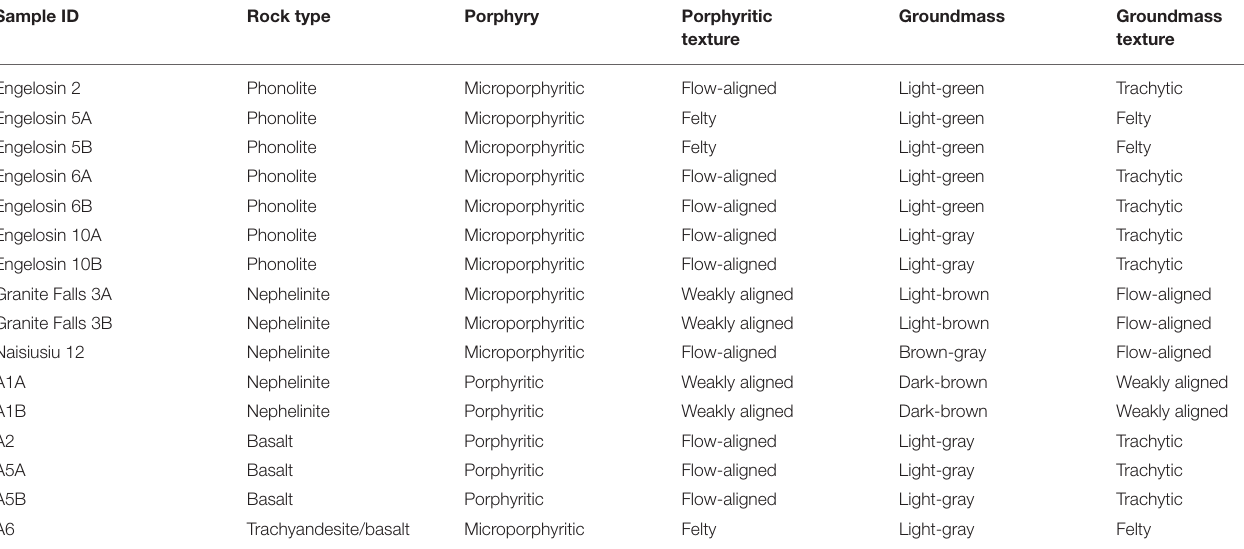
TABLE 3 | Textural data per magmatic